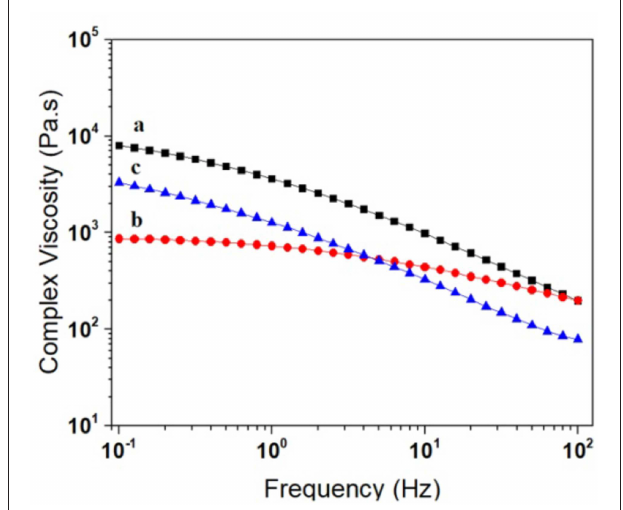
FIGURE 1 | Complex viscosity vs. frequency for (a) PS, (b) PBAT, and the (c) PS/PBAT = 50:50 wt.%